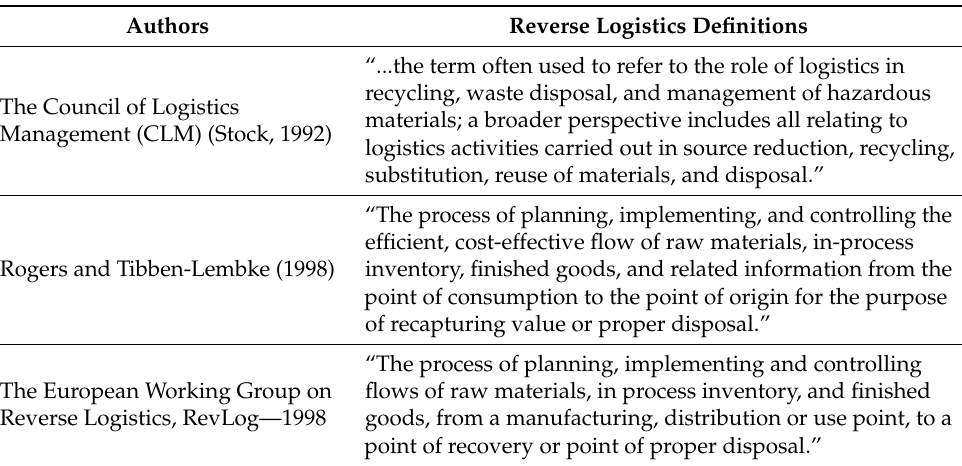
Table 1. Reverse logistics definitions in the literature most cited in the last 20